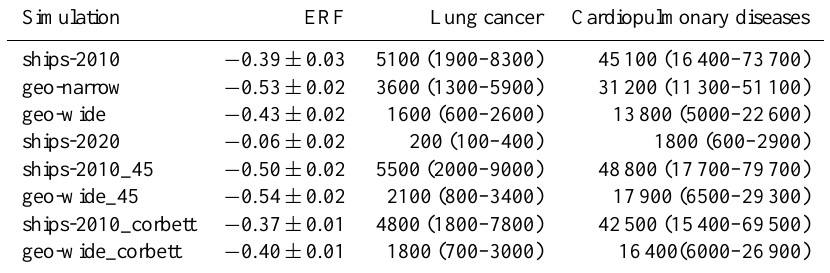
Table 2. Global mean effective radiative forcing (ERF) (Wm − 2 ) and global excess mortality due to shipping emissions (deaths per year) ∗ .